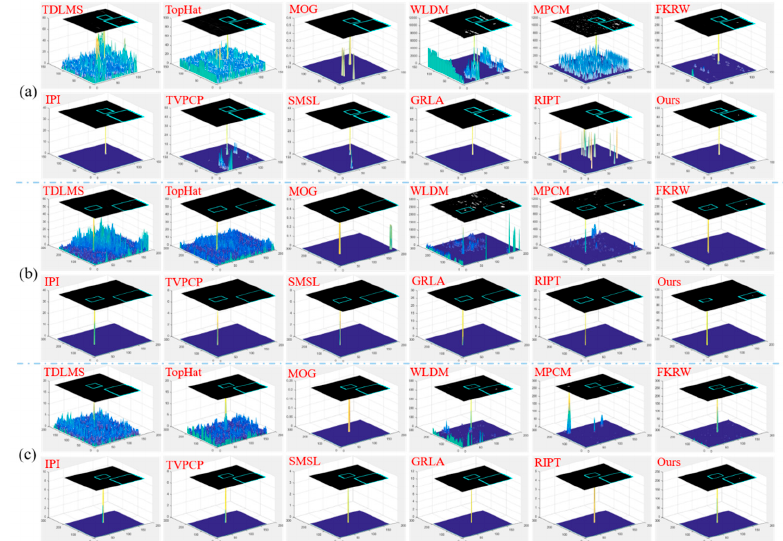
Figure 8. Detection results obtained by the proposed method over deep-space scenes compared with 11 comparative approaches. For better observation, the target images are integrated with their 3D stereogram. ( a ) Representative frame in Sequence 3. ( b ) Representative frame in Sequence 4. ( c ) Representative frame in Sequence 5.